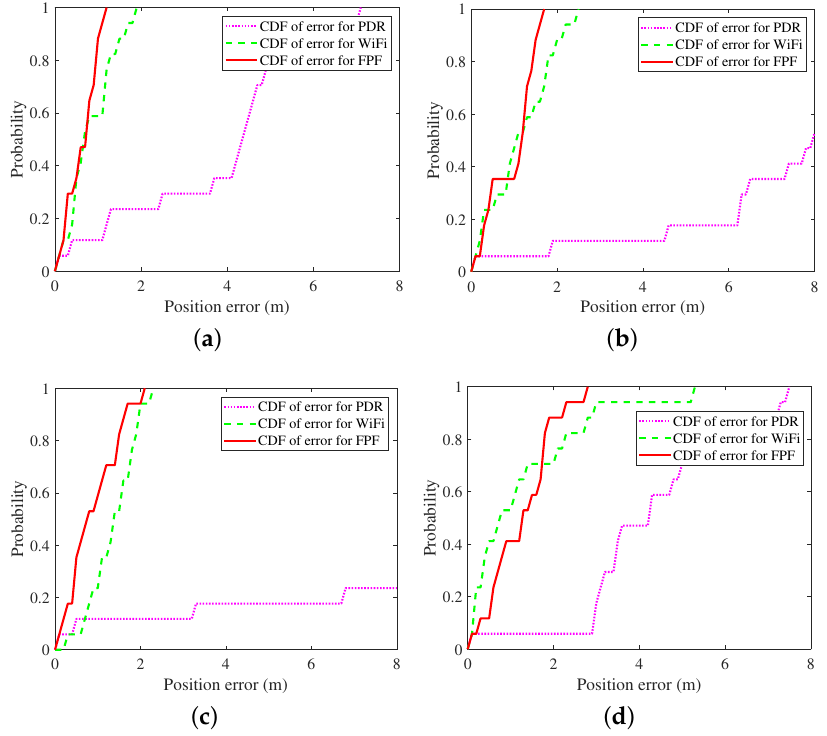
Figure 8. CDFs of errors with different modes. ( a ) CDFs of errors with calling mode. ( b ) CDFs of errors with dangling mode. ( c ) CDFs of errors with handheld mode. ( d ) CDFs of errors with pocketed